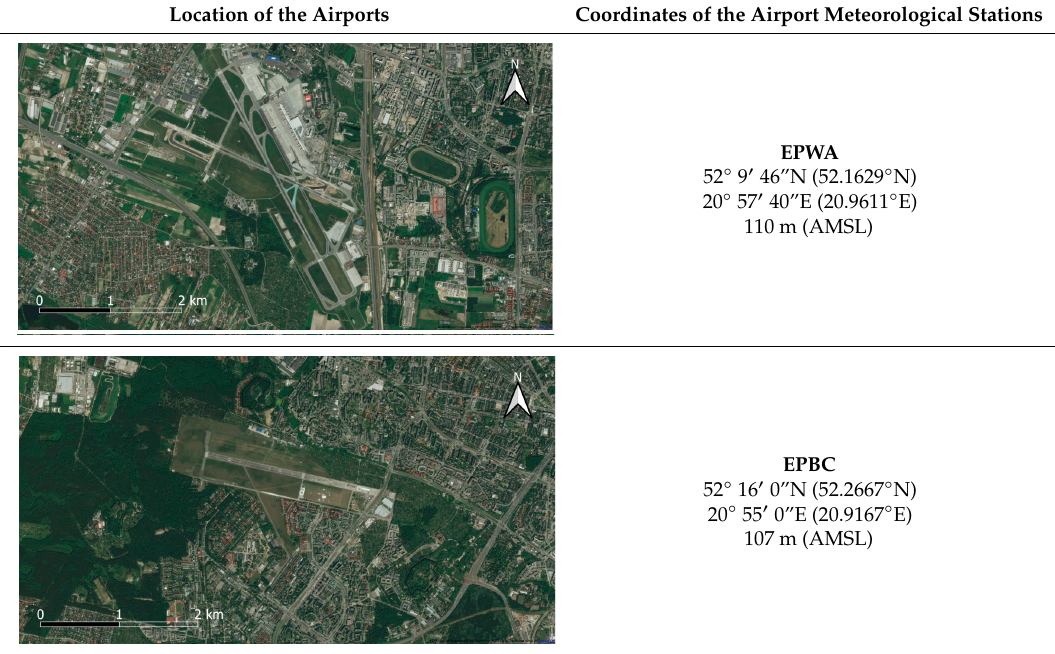
Figure 1. Visualization of the authors’ method for attaching the CORINE Land Cover (CLC) data to the WRF model for the CLC border areas, where first mesoscale calculation domains go beyond areas of the CLC coverage. Table 1. Location of meteorological station at the Warsaw airports. Location of the Airports Coordinates of the Airport Meteorological Stations